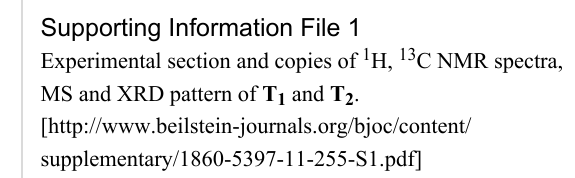
were all higher than those of T 1 ( = +0.514 V (I), = +0.841 V (II)). These changes indicated the formation of the CT